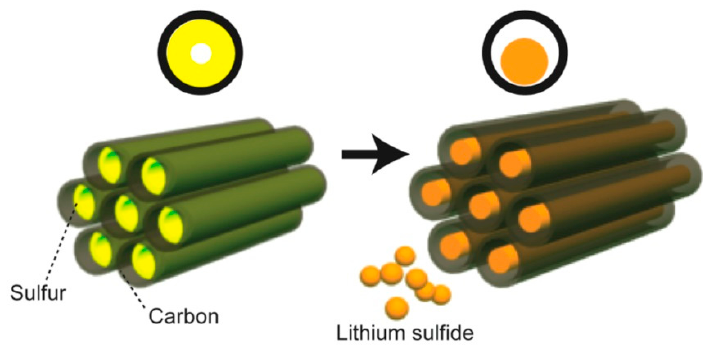
Figure 9. Changes in the morphology of nanotube-based sulfur cathode during discharge. Reprinted with permission from [149]. Copyright 2013 American Chemical Society.